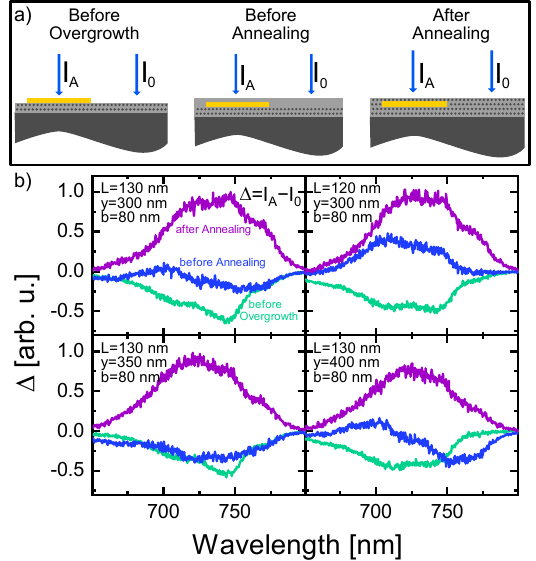
Figure 4. ( a ) The respective fabrication step for the measurement is displayed. For I A , the signal of an antenna field is measured, and I 0 is the area without antennas. ( b ) This shows the difference between these measurements for the respective fabrication step. Before overgrowth, the PL signal is attenuated because the antennas act as centers for scattering. After overgrowth, there is no uniform attenuation or enhancement. After annealing, the signal is amplified for all